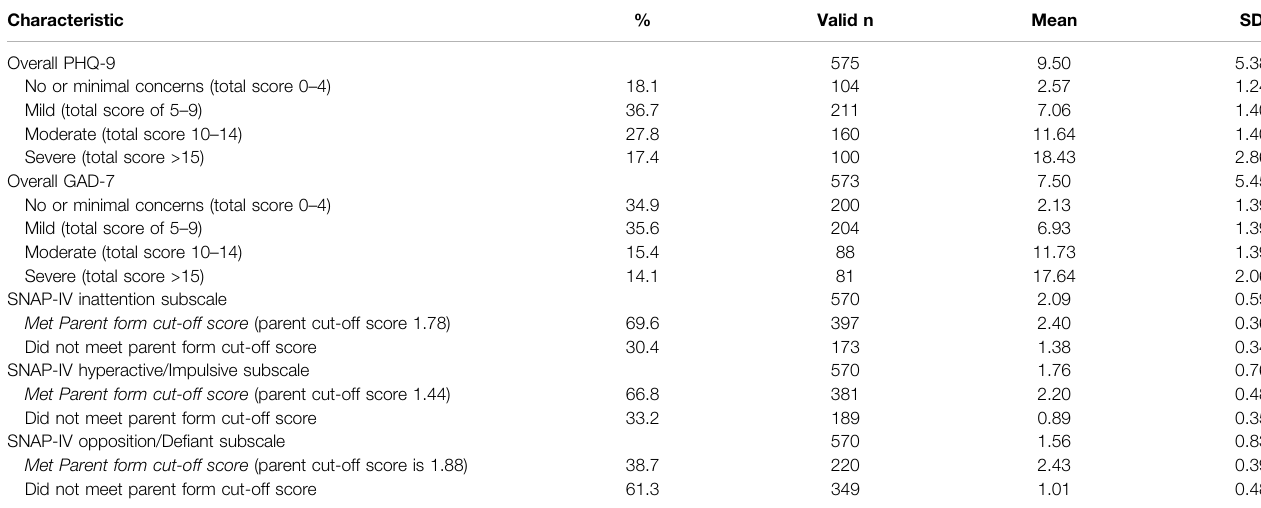
TABLE 2 | Mental health and executive function skills scores.